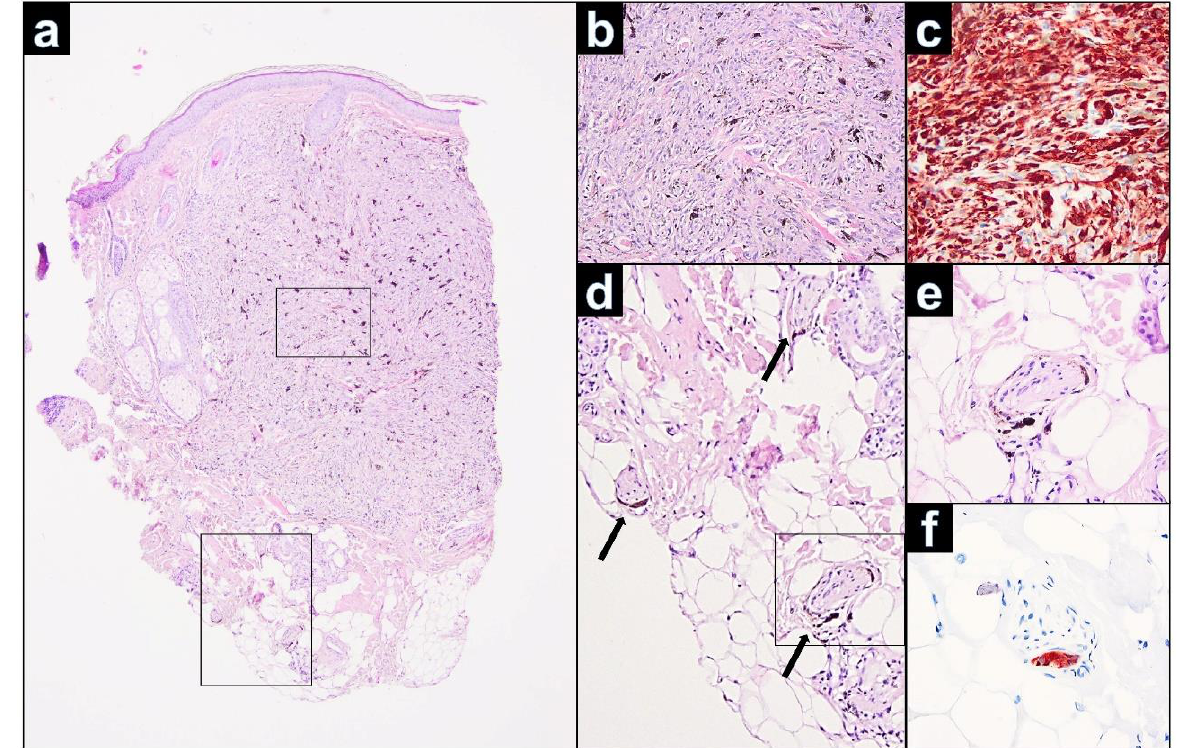
Figure 4. ( a ): Left forehead: primary CBN showing strongly pigmented melanocytes with dense fibrous stroma and melanophages. Cellular areas of CBN extend vertically into the deep reticular dermis (H&E, 25 × ). ( b ): Strongly pigmented oval-shaped, spindle-shaped, and dendritic melanocytes and melanophages, occupying the dermis. No features suggestive of malignancy were seen, such as cytological atypia, atypical mitoses, or necrosis (H&E, 200 × ). ( c ): The tumor cells are diffusely positive for Melan-A. ( d ): Small groups of melanocytes and melanophages colonize the endoneurium of small nerves (black arrows) (H&E, 40 × ). ( e ): Presence of blue nevus melanocytes in the wall of a peripheral nerve fiber (H&E, 400 × ). ( f ): Immunohistochemically, the melanocytes in the wall of the nerve fiber are strong positive for Melan-A (Melan-A, 400 ×